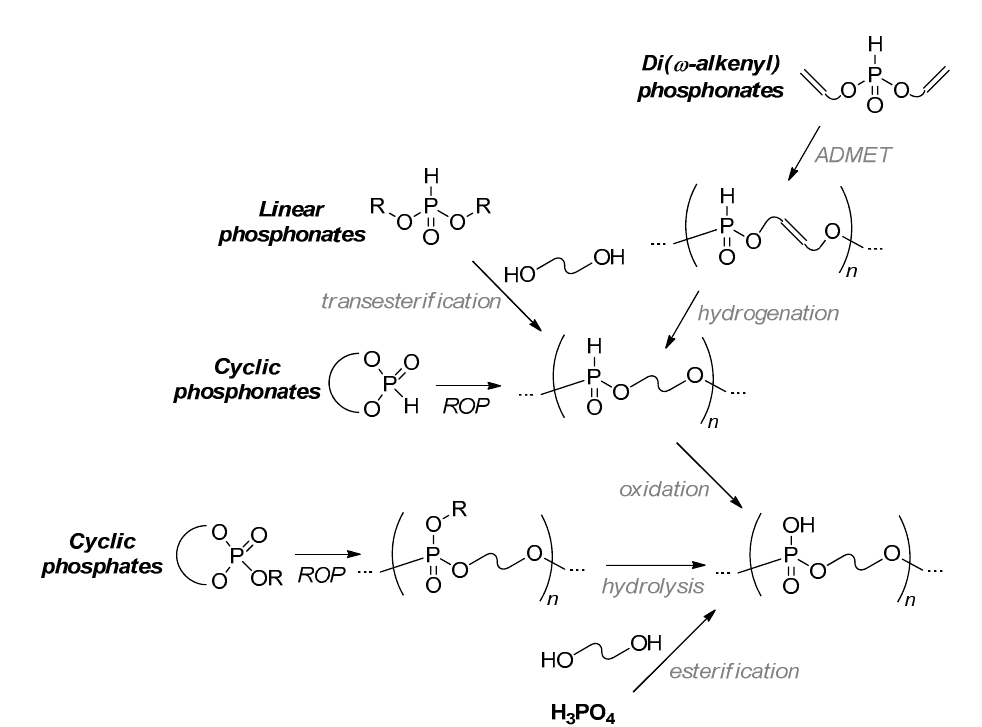
Scheme 2. General synthetic approaches to